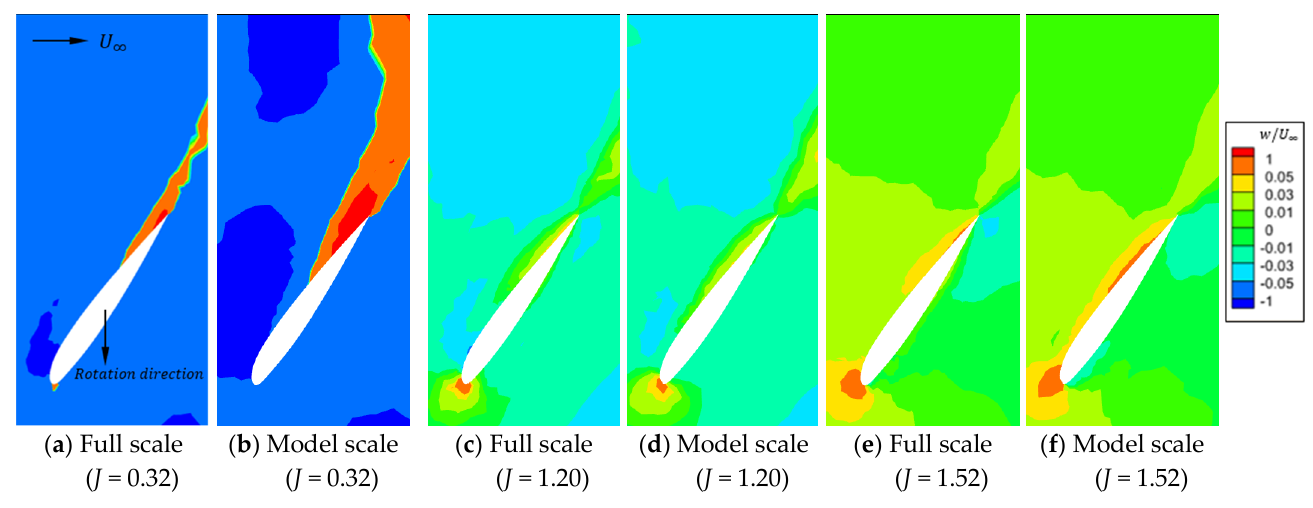
Figure 18. Flow field for spanwise velocity ratio, w / U ∞ at r/R = 0.75.